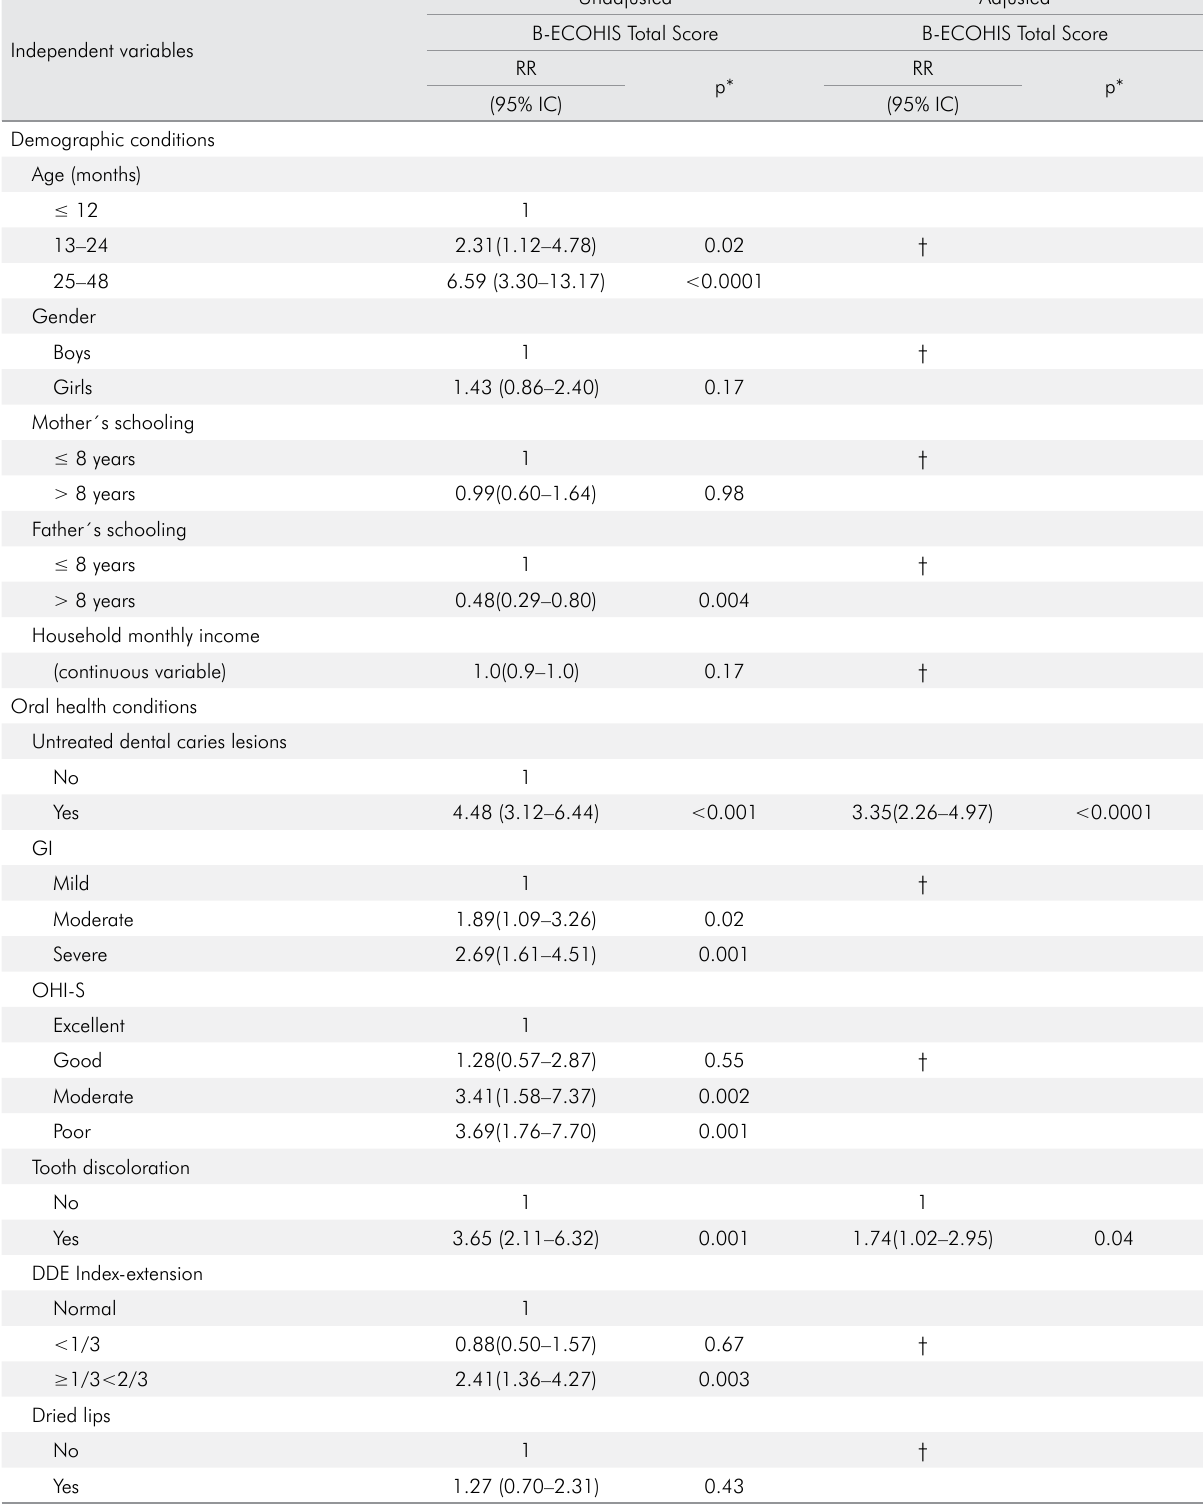
Table 3. Unadjusted and adjusted regression model of the demographic characteristics and oral health conditions variables associated with total scores of the Brazilian Early Childhood Oral Health Impact Scale